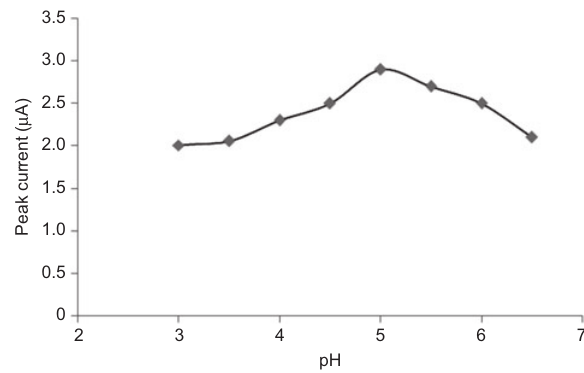
Figure 4 Infl uence of pH on the anodic peak current response for 1.0 × 10 -4 m gatifl oxacin in acetate buffer (pH 3.0 – 6.5) after 60 s depo- sition time and pulse amplitude of 50 mV.